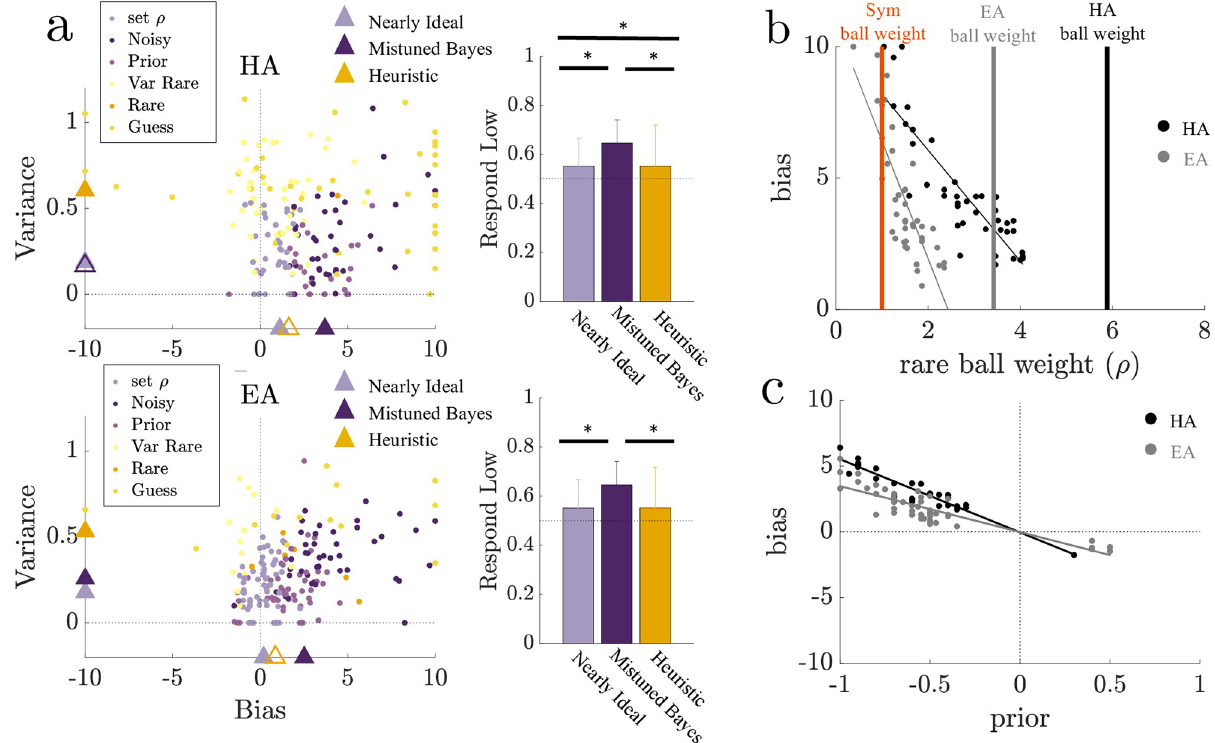
Fig 5. Increased bias and variance in asymmetric blocks corresponded to Bayesian subject model fits with mistuned parameters and heuristic subject model fits, respectively. a. Left: Hard Asymmetric (HA) and Easy Asymmetric (EA) block bias-variance plots from Fig 3E and 3F, color-coded according to each subject’s best-fitting model described in Fig 4D. Triangles denote median values for the bias-variance fits for: 1) Nearly Ideal subjects (best fit by “Noisy Bayesian Set ρ ” model), 2) Mistuned Bayesian subjects (best fit by “Noisy Bayesian” or “Prior Bayesian” models), 3) Heuristic subjects (best fit by “Variable Rare”, “Rare Ball”, or “Guess” models). Mistuned Bayesian and Heuristic groups that significantly (not significantly) differ from the Nearly Ideal group are denoted by filled (open) triangles based on a Wilcoxon rank-sum test with p < 0.05. Right: Group bootstrapped means (1000 iterations) and 95% confidence intervals for low-jar responses. Statistically significant differences between groups (two-sided t -test with unequal variance, p < 0.05) are noted with an asterisk. b. Estimated subject bias obtained from best–fit psychometric functions compared with the maximum- likelihood estimate (MLE) of the rare-ball weight, ρ , for subjects best fit by the Noisy Bayesian model in asymmetric blocks (dots, EA-grey, HA-black). Regression lines are shown for group-blocks with significant correlations (Spearman correlations, p < 0.05). Vertical lines indicating the rare-ball weights used by the ideal observer for each asymmetric block and symmetric blocks (orange) are included for reference. c. Estimated subject bias from fit psychometric functions compared with the MLE of the response bias (Prior) for subjects best fit to the Prior Bayesian model in the asymmetric block (marker legend as in b ). Negative values correspond to a bias in favor of the low